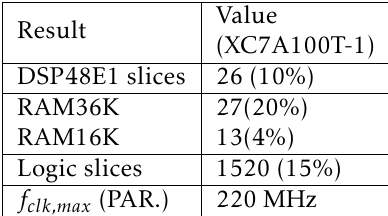
Table 3. FPGA resource utilization and clock frequency for